Question: Which visualization type does this figure use?
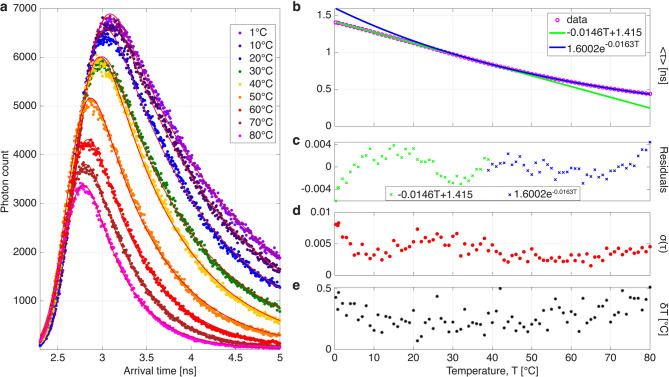
Answer: histogram